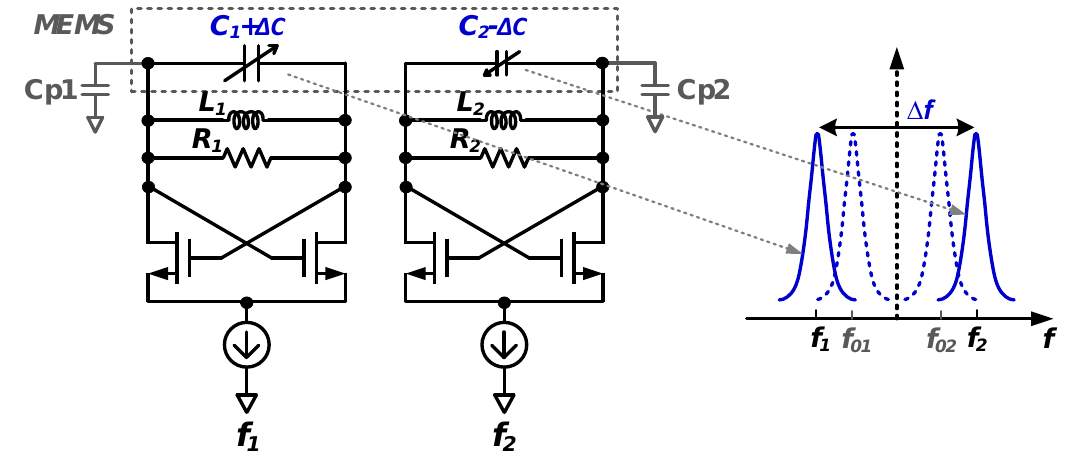
Figure 5. Simplified principle of an LC-oscillator-based interface circuit for MEMS accelerometers. Due to the change of MEMS capacitances ( ± ∆ C ), f 1 decreases and f 2 increases from their initial frequencies f 01 and f 02 , respectively.